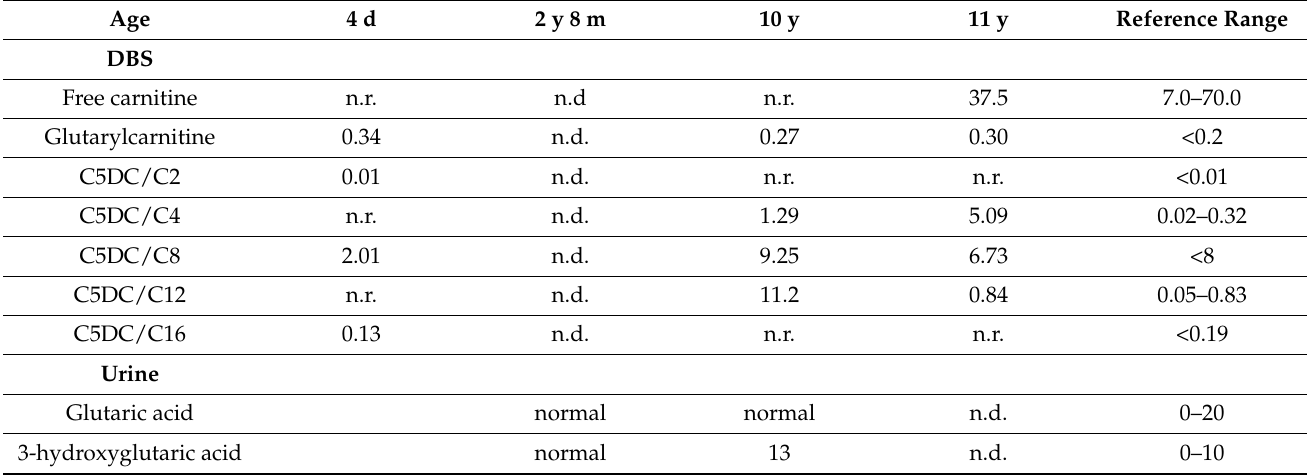
Table 2. Laboratory results of patient 2. Free carnitine and glutaryl-carnitine are in µ mol/L; organic acids are in mmol/mol creatinine. n.r. = not reported; n.d. = not